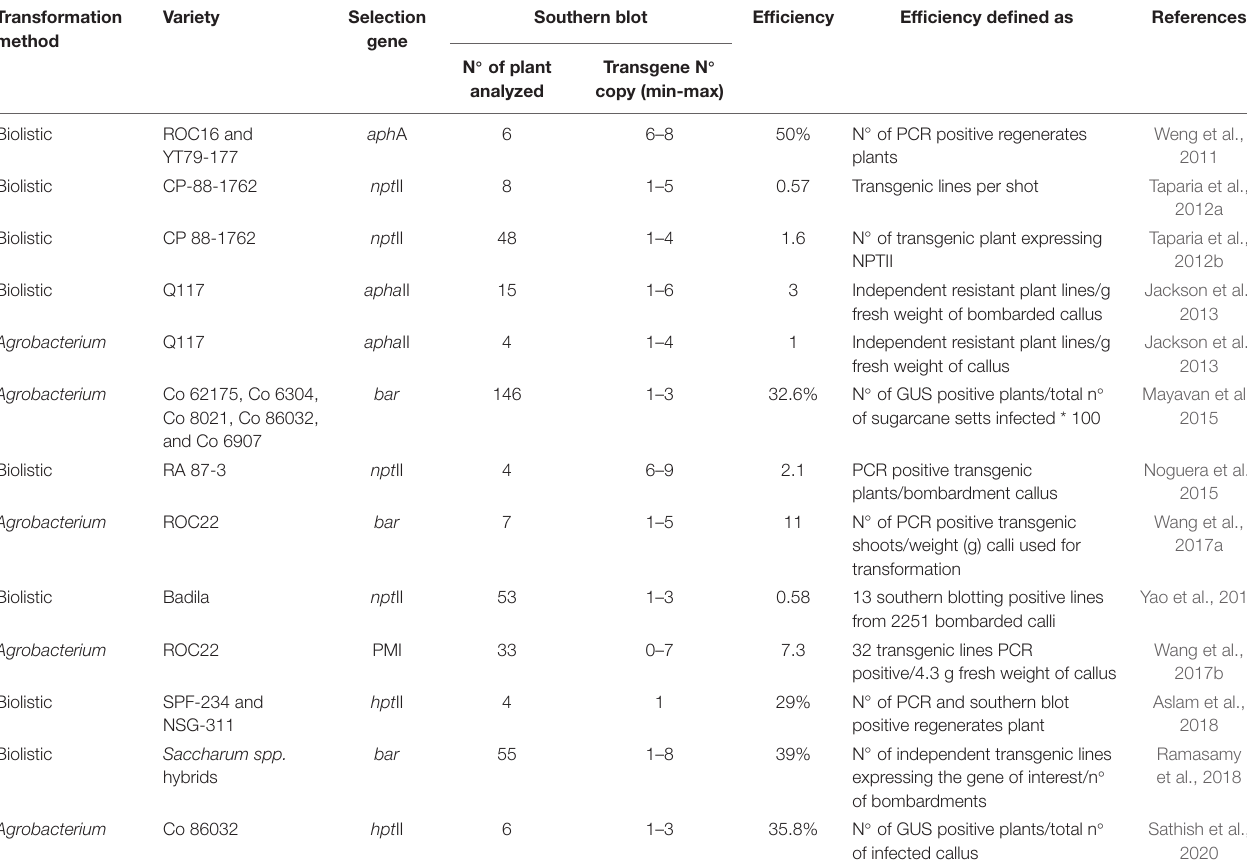
TABLE 1 | Transformation efficiency and copy numbers determined by Southern blot analysis for biolistic and Agrobacterium -methods in sugarcane during the last